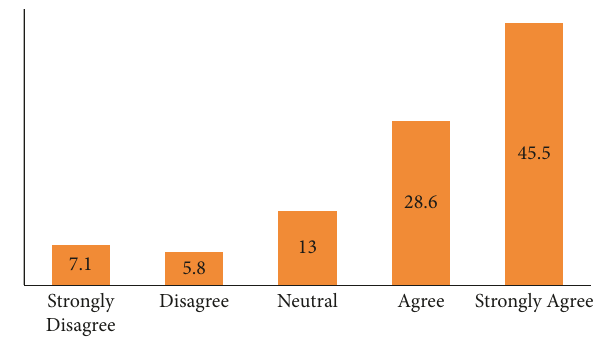
Figure 1: Cost effectiveness. Table 2: Secured data sharing.